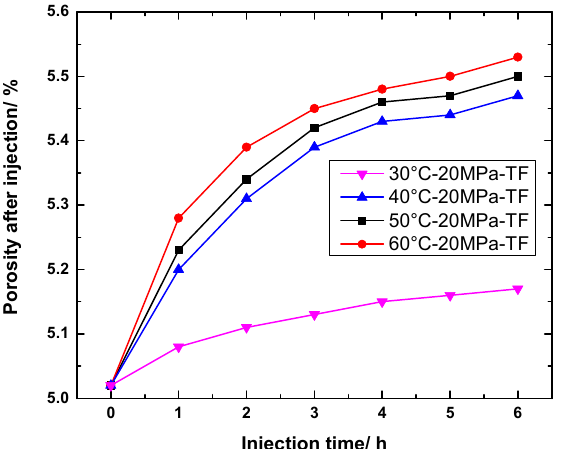
Figure 8. Variation in porosity with time for TF specimens at different temperatures under the same pressure of 20 MPa.